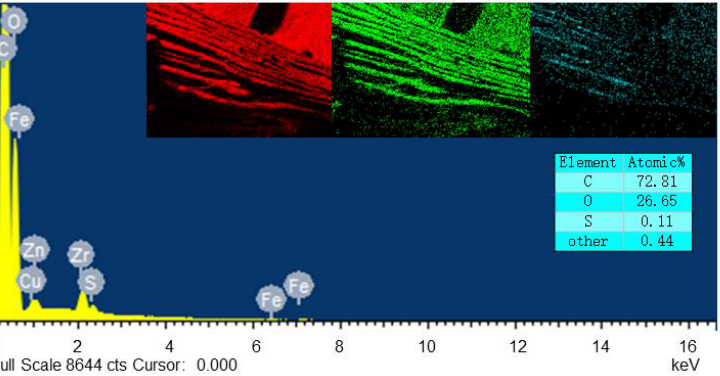
Figure 10. EDS Analysis of Element Content of Impregnated Layer on PET Fiber